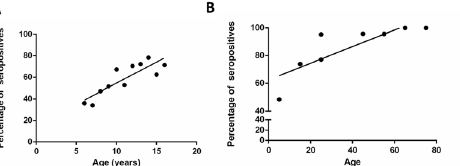
Fig 1. Seroprevalence of dengue infections. A: Age stratified seroprevalence of DENV-specific antibodies in children. B: Age stratified seroprevalence of DENV-specific antibodies in